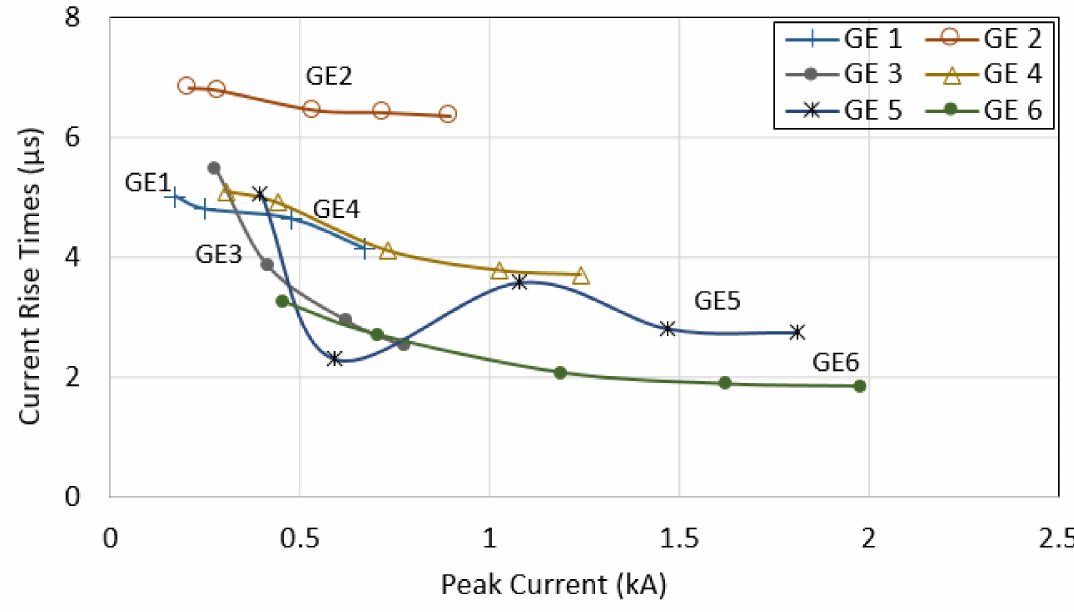
Figure 5. Current rise times for GEs at various peak current magnitudes under negative impulse